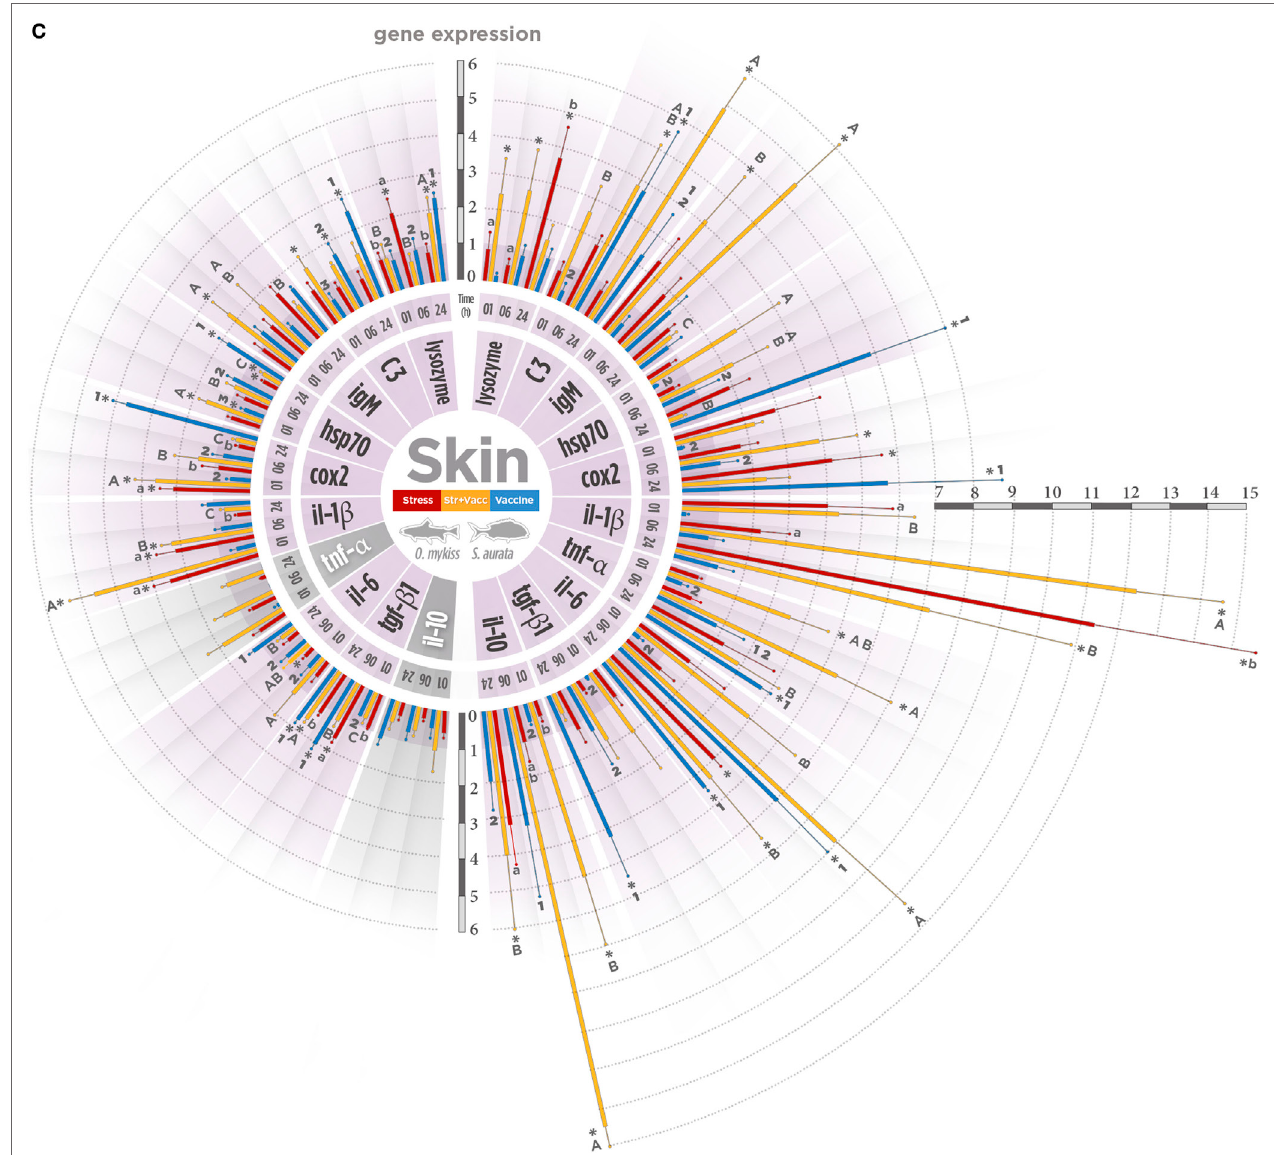
FigUre 2 | Gene expression level in skin-associated lymphoid tissue (SALT) after a biotic ( Vibrio anguillarum bacterin), abiotic (air exposure), or the combination of both stressors (vaccine + air exposure) at 1, 6, and 24 h post-stress. Quantitative real-time PCR quantification of specific mRNA immune and stress transcripts ( lysozyme , c3, igm, hsp70, cox2, Il1 β , tnf α , il6, tgf β 1 , and il10 ) in (a) rainbow trout and (B) gilthead seabream skin. (c) Integrative comparison of SALT transcriptomic responses. β -Actin and 18s were chosen as housekeeping genes in rainbow trout and gilthead seabream, respectively. Different colors indicate different treatments: red (air exposure), orange (vaccine + air exposure), blue (vaccine), and gray (ctrl). Time zero represents the end of the acute air exposure stress (for the air exposure and the vaccine + air exposure) or 24 h after bath vaccination (for vaccine group). Data are represented as mean ± SE ( n = 8 per sampling time point). Significant differences are indicated by lower case in the air exposure group, by upper case in the vaccine + air exposure group, and by numbers in the vaccine group. Asterisk (*) indicates significant difference of each treatment versus control ( p <